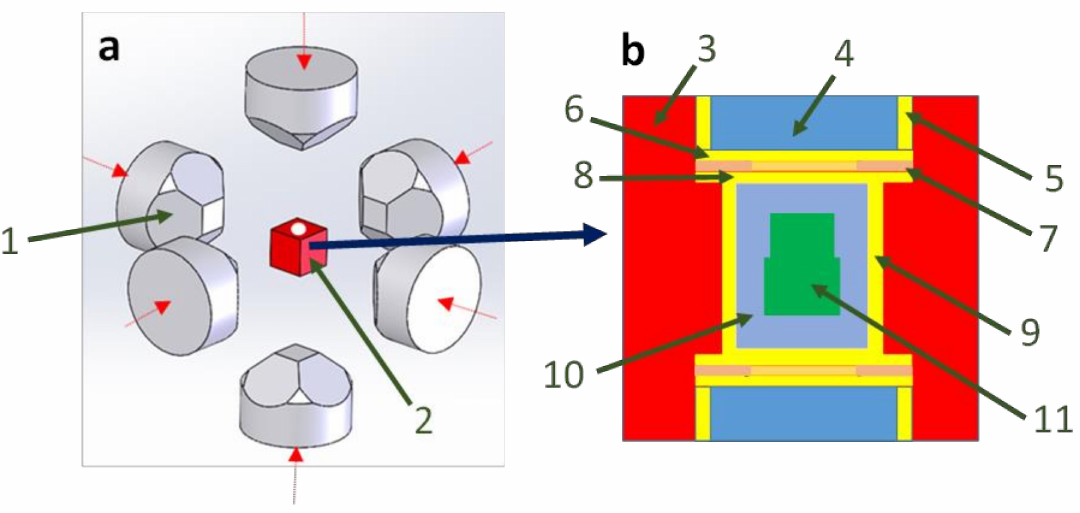
Figure 7. ( a ) Schematic of cubic press assembly showing the six opposite WC anvils and the cube assembly in the middle; ( b ) Enlargement of the associated cubic reaction chamber. (1) WC anvils. (2) Cubic reaction chamber. (3) Gasket material. (4) “Synthetic gasket material”. (5) Steel electrode. (6) First metallic disk. (7) Baffle. (8) Second metallic disk. (9) Graphite heater. (10) Salt capsule. (11) Metallic capsule where the sample is placed. The red arrows indicate compression axes. Adapted from